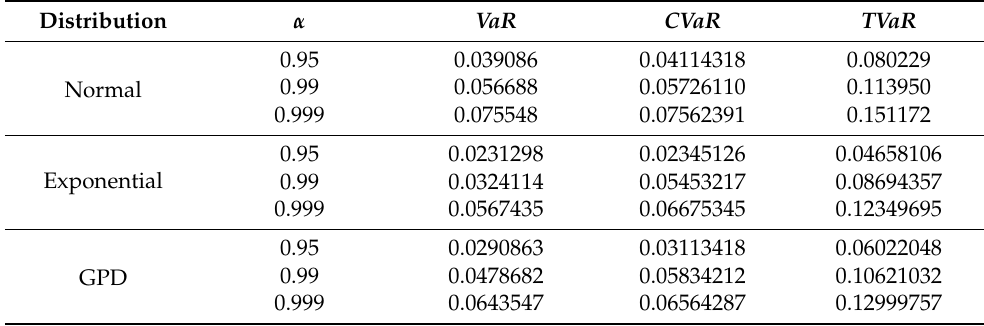
Table 3. Values of VaR, CVaR , and TVaR .